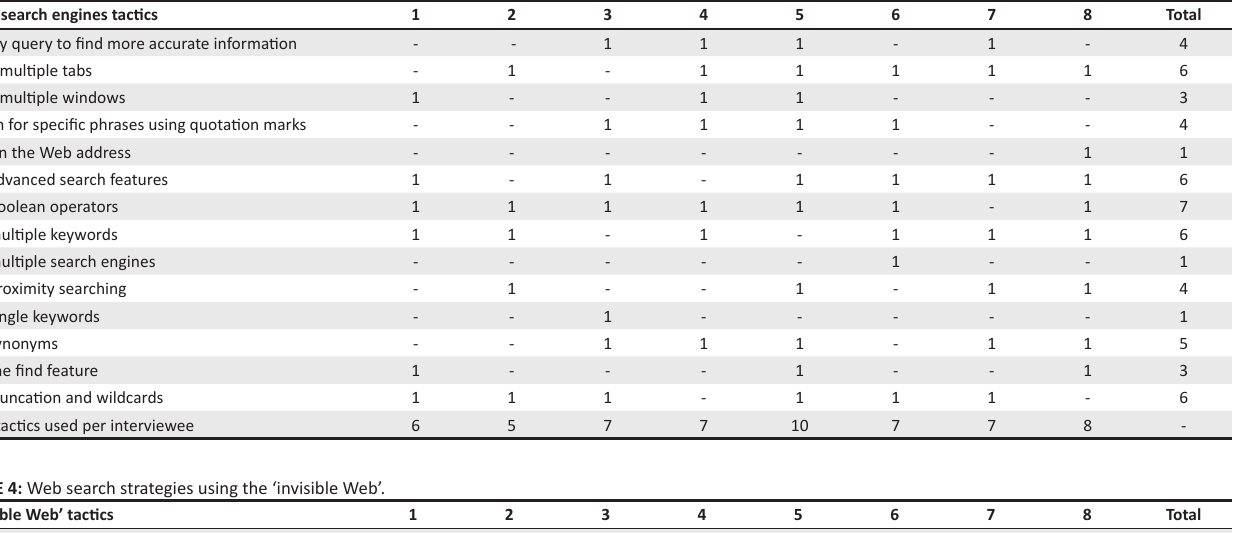
TABLE 3: Web search strategies using meta-search engines.